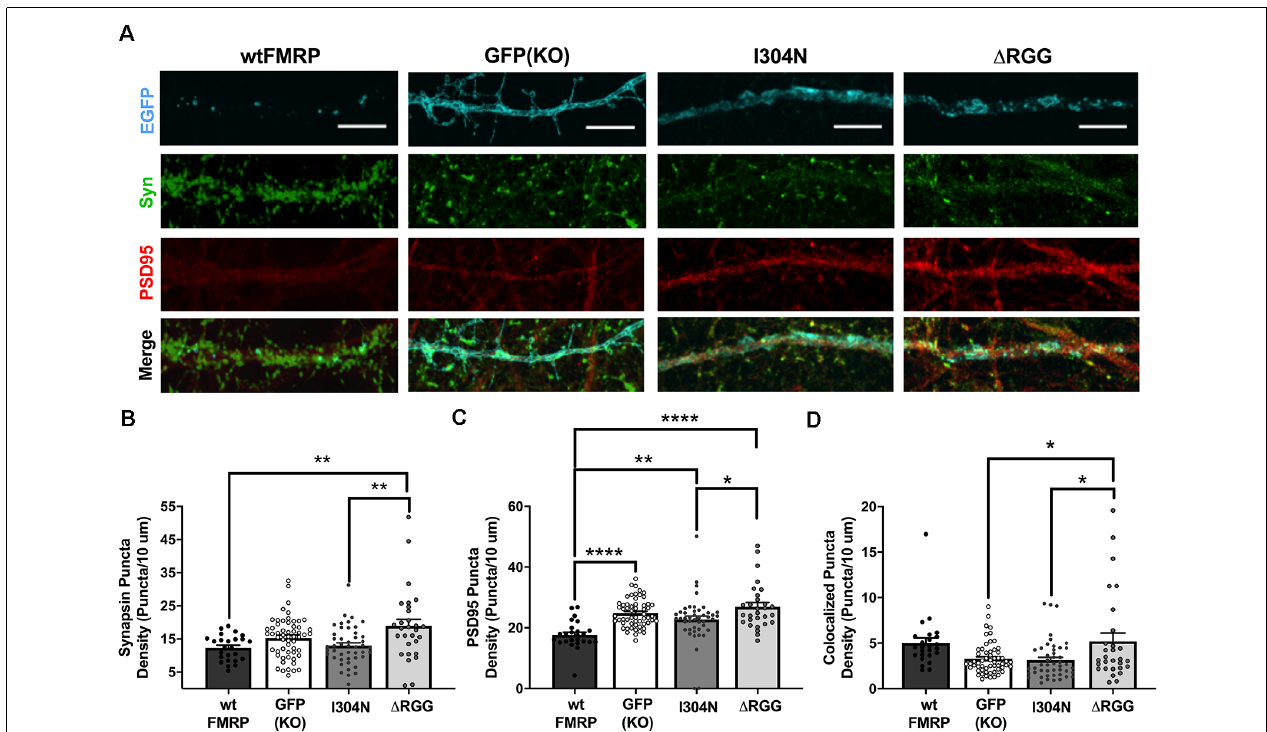
FIGURE 3 | Expression of presynaptic (synapsin I; green) and postsynaptic (PSD95; red) markers at day in vitro (DIV) 14 in Fmr1 knockout (KO) MSNs transfected with either green fluorescent protein (GFP) alone, or various forms of EGFP-tagged FMRP ( A ; scale bars are 10 µ m). Cells transfected with ∆ RGG-FMRP have a higher density of synapsin than those transfected with wt- or I304N-FMRP ( B ; one-way ANOVA). Cells transfected with wt-FMRP had significantly decreased density of PSD95 puncta, while those transfected with I304N- or ∆ RGG-FMRP did not differ from GFP (KO) controls ( C ; one-way ANOVA). Cells transfected with ∆ RGG-FMRP had a greater density of colocalized synapsin and PSD95 puncta compared to those transfected with I304N-FMRP and GFP (KO) controls ( D ; one-way ANOVA). Significant Bonferroni comparisons are indicated (* p < 0.05, ** p < 0.01, **** p < 0.0001); data shown are mean ±